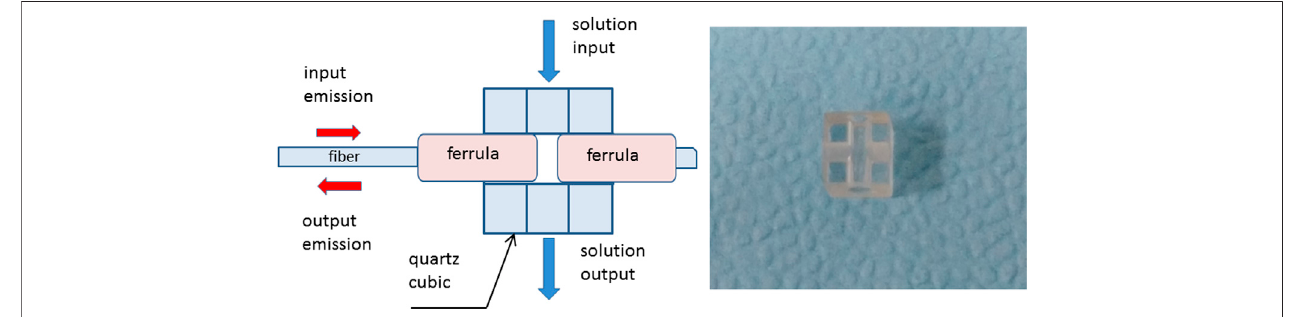
FIGURE 3 | The sketch and photo of the measuring